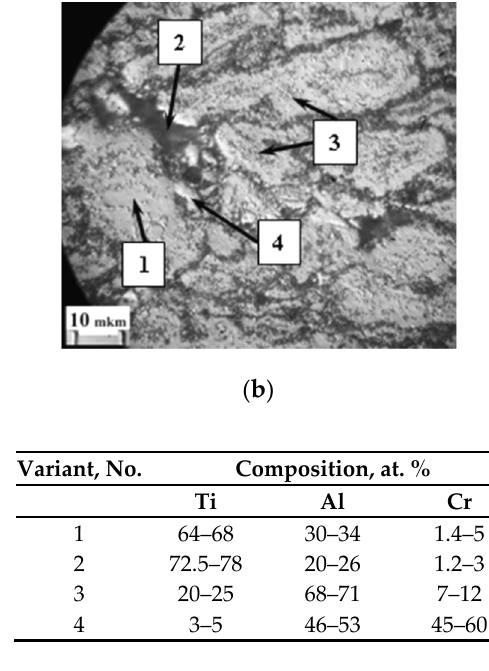
4 of 18 Figure 1. Morphology of the surface of the particles of powders: ( a ) the copper; ( b ) the tin; ( c ) the elemental graphite GE-1; ( d ) the silicon carbide; ( e ) the titanium dioxide; ( f ) the intermetalide Ti- 46Al-8Cr. The TI-46AL-8CR system was obtained by the method of the mechanoactivated self-